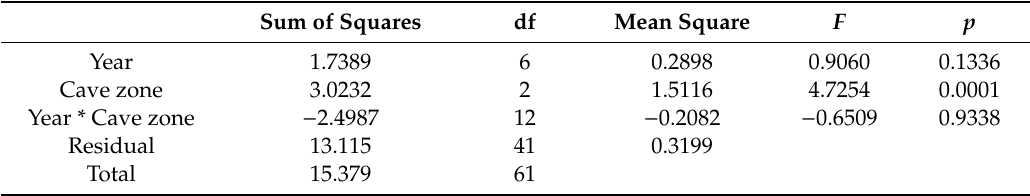
Table 3. Results of the two-way PERMANOVA (9999 permutations) comparing the temporal and spatial variation of the faunal community sampled along the Biospeleological Station of San Bartolomeo from 2013 to 2019. Sum of Squares df Mean Square F p 1.7389 0.2898